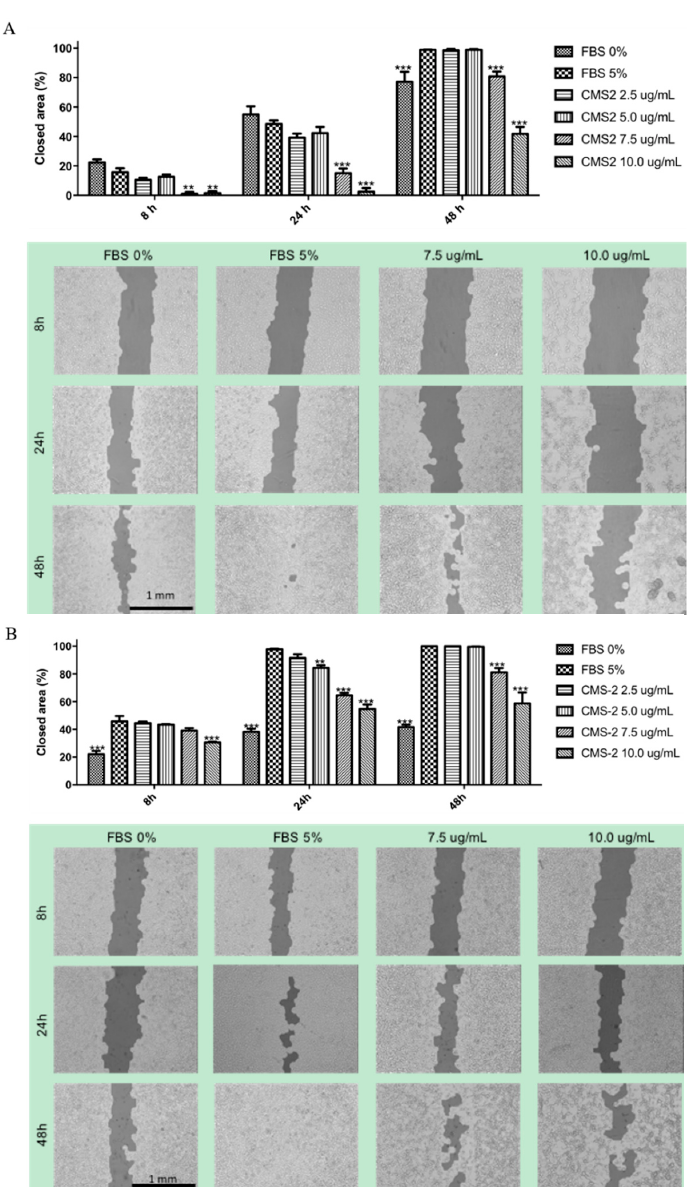
Figure 7. CMS ‐ 2 inhibits migration of melanoma and melanocyte cell line. Cell migration was Figure 7. CMS-2 inhibits migration of melanoma and melanocyte cell line. Cell migration was evaluated evaluated by the scratch assay 0, 8, 24 and 48 h of CMS ‐ 2 treatment (2.5–10  g/mL). Representative by the scratch assay 0, 8, 24 and 48 h of CMS-2 treatment (2.5–10 µ g/mL). Representative images images and quantification of the closed area for: B16 ‐ F10 ( A ); and Melan ‐ a ( B ). ** p < 0.01 and *** p < and quantification of the closed area for: B16-F10 ( A ); and Melan-a ( B ). ** p < 0.01 and *** p < 0.001, 0.001, Analysis of variance, Bonferroni post ‐ test. The positive control was 5% fetal bovine serum (FBS) Analysis of variance, Bonferroni post-test. The positive control was 5% fetal bovine serum (FBS) and and the negative control was 0% FBS. The images were taken with 4× magnification. the negative control was 0% FBS. The images were taken with 4 ×